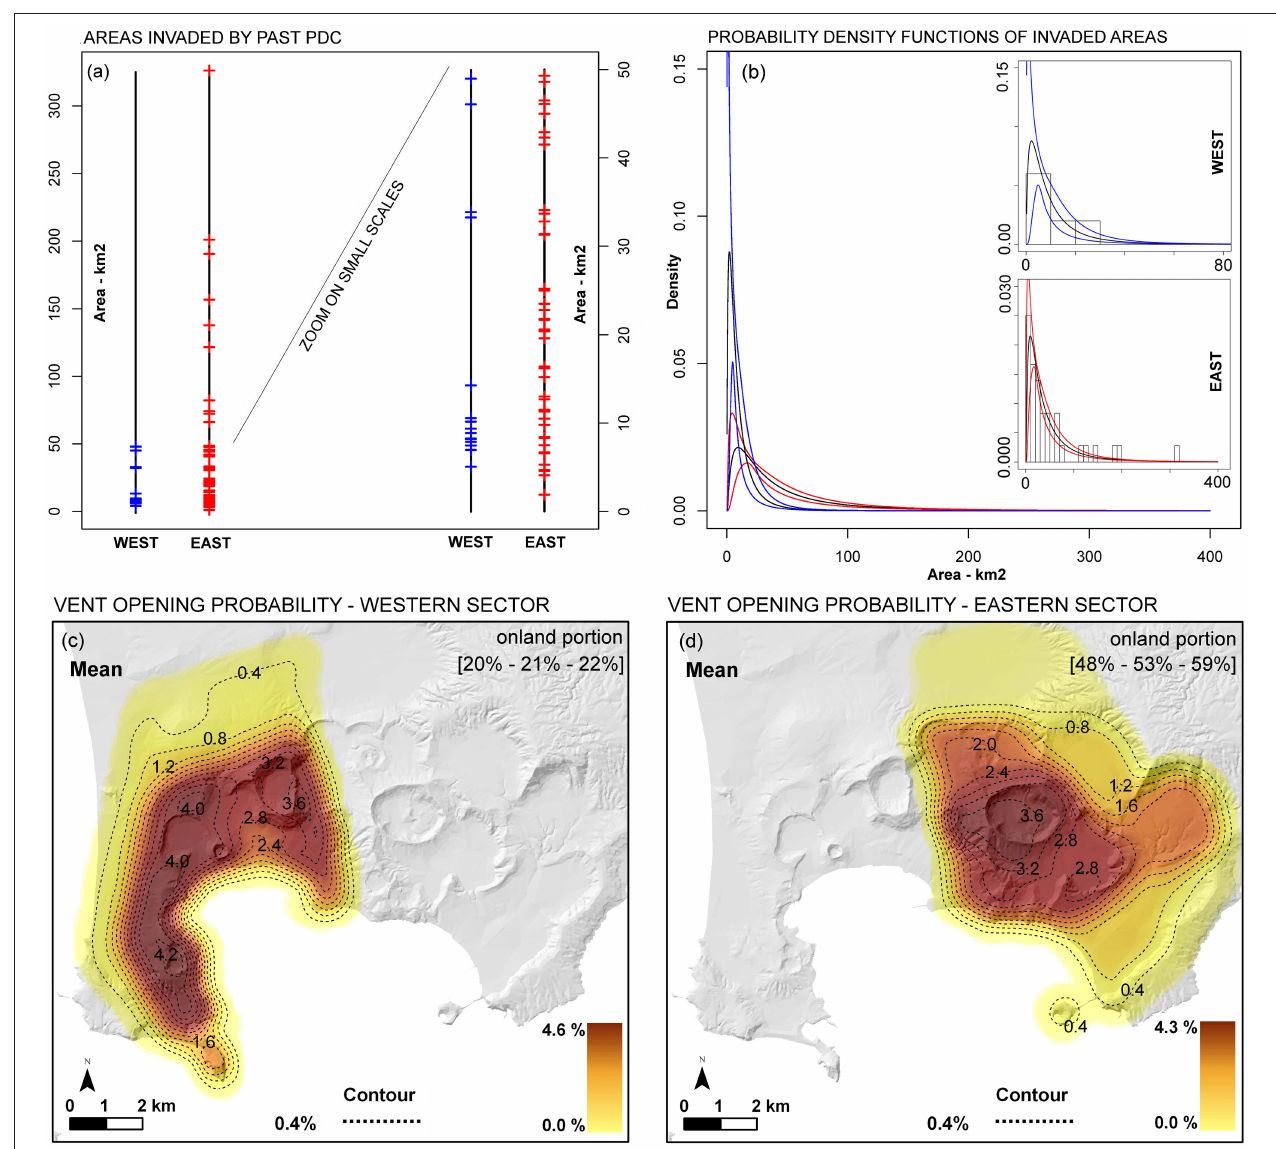
FIGURE 3 | (a) Representation of the areas invaded by past PDC originating in the western (blue) or eastern (red) sectors of the caldera. Each colored dash represents an event. The sequence is ordered increasingly as a function of the areal extents. On the right of the plot is displayed a zoom of the small scales data. (b) Probability density functions (log-normal class) for the invasion areas originating in the western (blue) or eastern (red) sectors of the caldera. The black curve is the mean value and the colored curves are the 5th and 95th uncertainty bounds. In the small boxes the two estimates are displayed at different scales and the histogram data are included. (c,d) Probability maps of new vent opening location modified from Bevilacqua et al. (2015). Contours and colors indicate the mean percentage probability of vent opening per km 2 conditional on the occurrence of an eruption originating on-land in the western (c) or in the eastern (d) sector of the caldera. Percentage vent opening probability values of the two on-land sectors, according to Figure 2a , are displayed with their 5th and 95th uncertainty bounds. Please note that the average probabilities of the two sectors do not sum to 100% due to the significant probability of vent opening in the underwater portion of the caldera (25 ± 5%